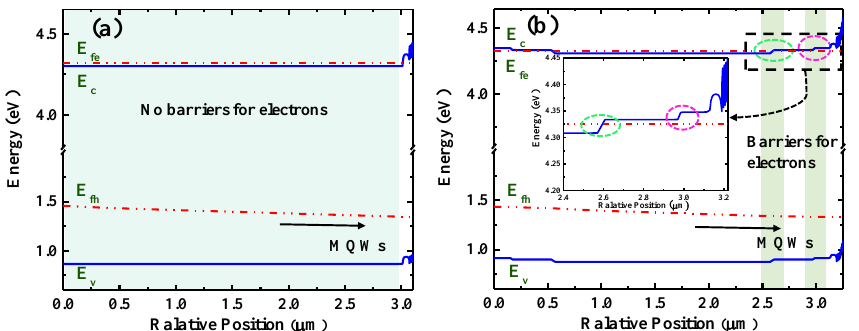
Figure 6. Energy band diagram for ( a ) the Device S 0 and ( b ) Device S 1 , E c , E v , E fe and E fh denote as the conduction band, valance band and the quasi-Fermi level for electrons and holes, respectively. The inset exhibits the partial enlarged view of black dotted line frame.